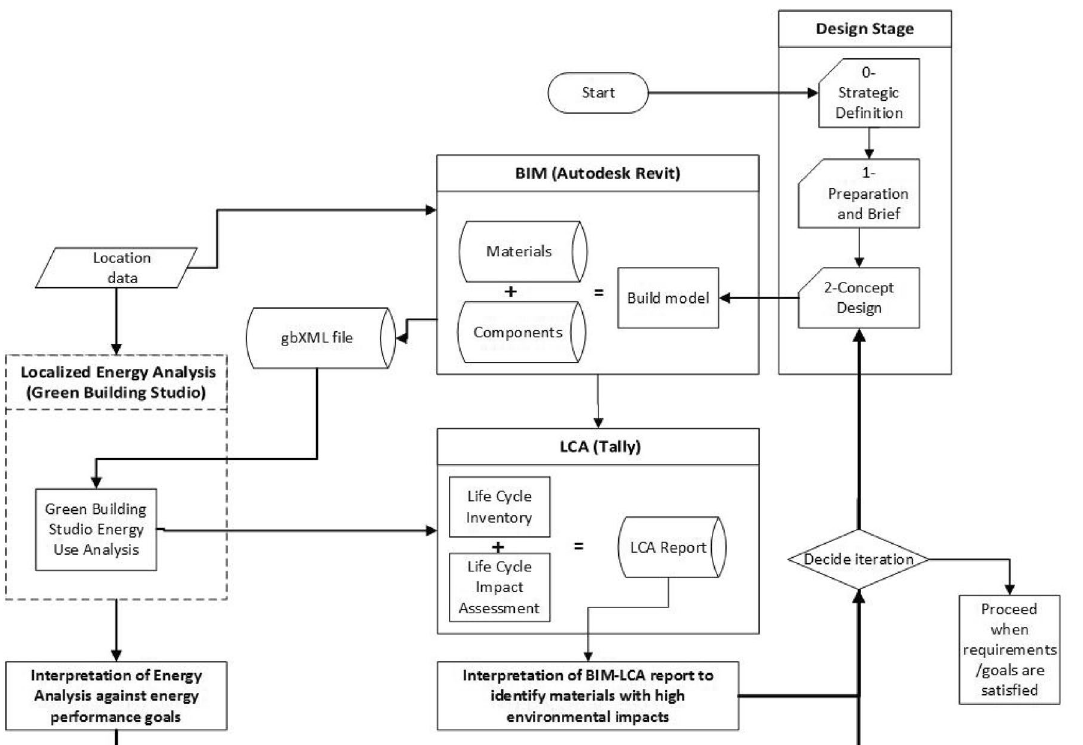
Fig. 5 Process of BIM-LCA + energy simulations used in action case